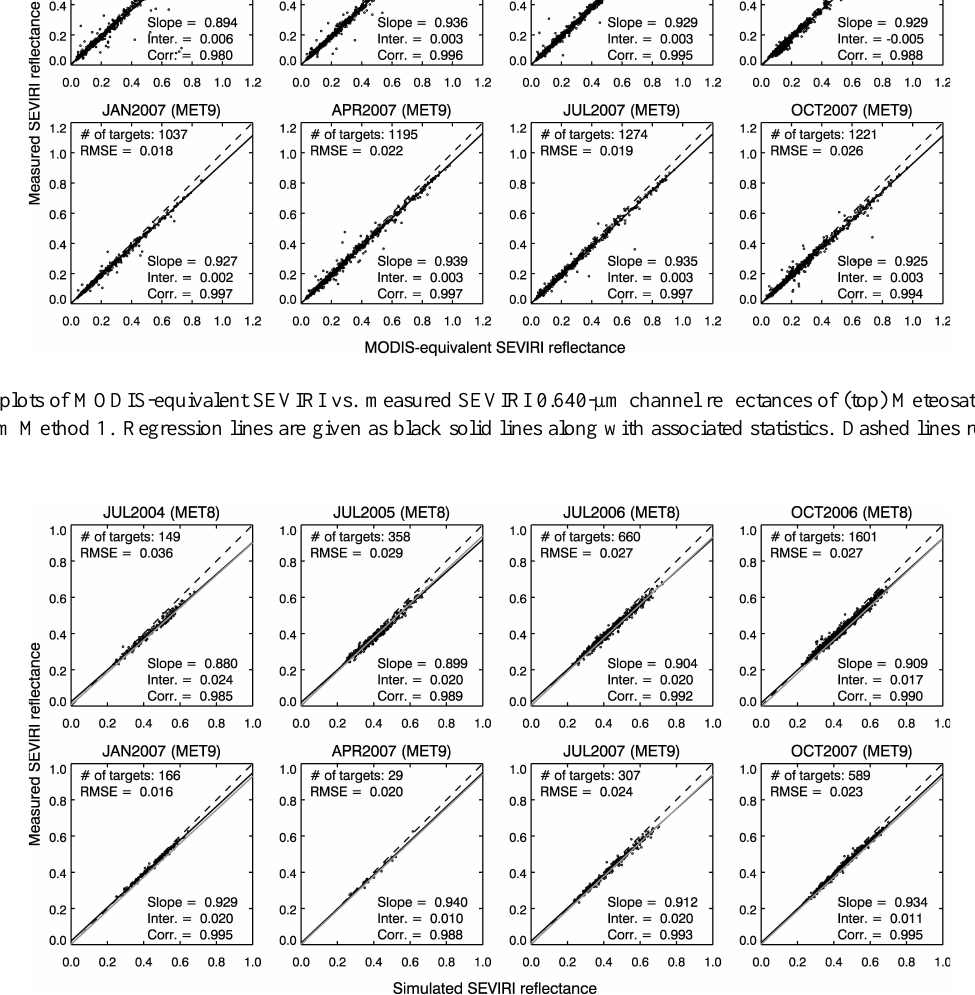
Fig. 8. Scatter plots of simulated vs. measured SEVIRI 0.640-µm channel reflectances of (top) Meteosat-8 and (bottom) Meteosat-9 from Method 2. The simulation is performed for cloud targets using collocated MODIS cloud products. Linear regression results are displayed as black solid lines along with associated statistics. Regression lines from Method 1 are also displayed as grey solid